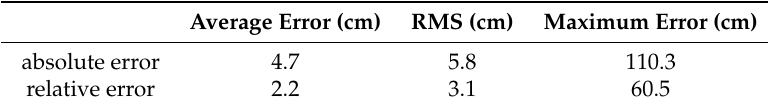
Table 1. Leica Pegasus 3D model precision